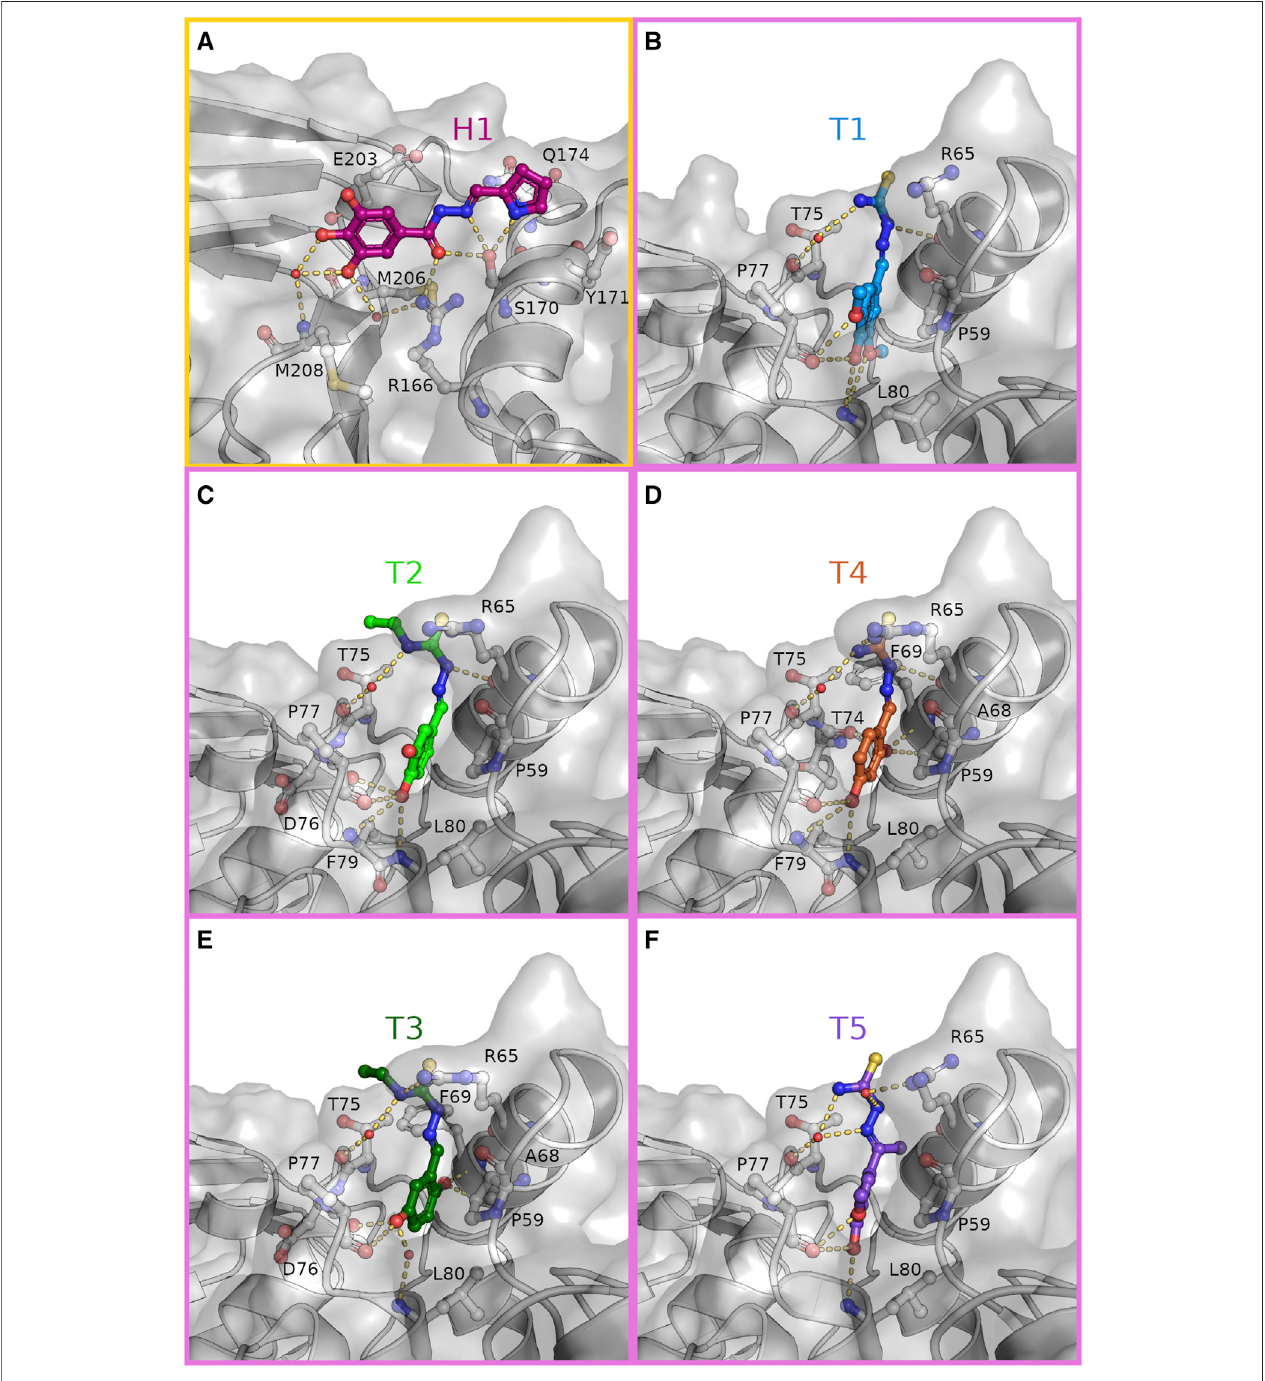
FIGURE 3 | Hydrazone and thiosemicarbazones are stabilized in their binding positions by an extensive hydrogen bonding network. Close-up view on the binding ofH1[ (A) ,magenta]totheS1site(yellowframe)andT1-T5 (B – F) totheS2site(pinkframes).Compoundsandinteractingresiduesareshownasstickswithcompounds highlighted by individual colouring. Possible interactions within hydrogen bonding distance with the surrounding residues are shown as dashes.